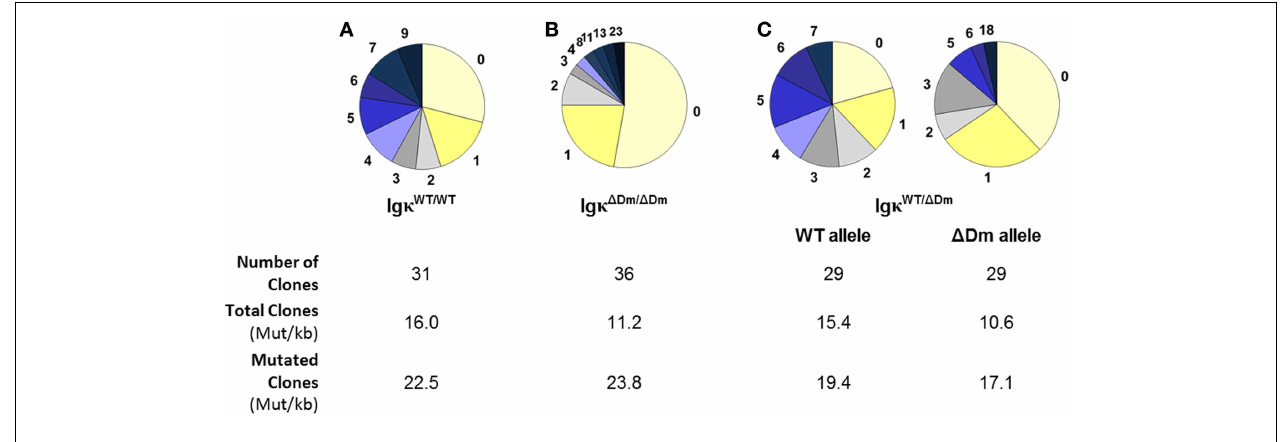
indicate the number of mutations sequenced in a 188-bp region immediately downstream of theV κ –J κ 5 joint. Number of colonies sequenced from each mouse and mutation rate per kilobase in total and mutated clones are